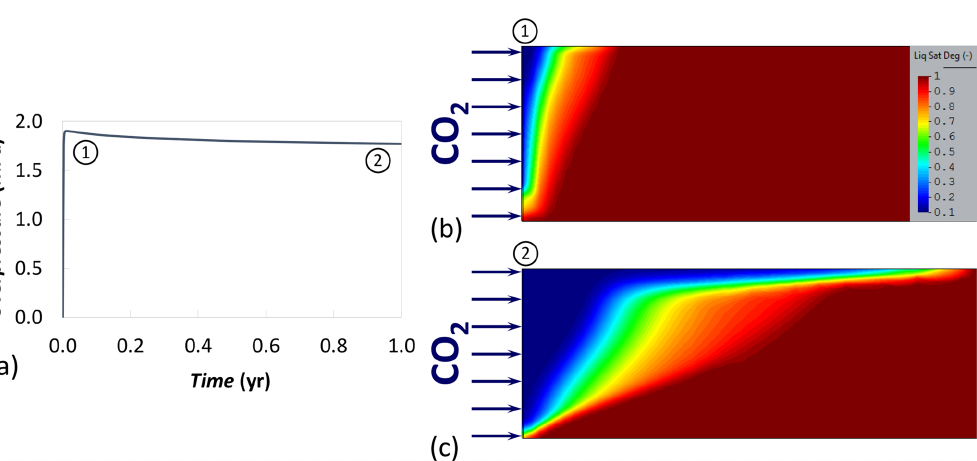
Figure 3. (a) CO 2 pressure evolution when injecting 1Mtyr − 1 of CO 2 through a vertical well in a 100m thick aquifer with an intrinsic permeability of 10 − 13 m 2 and a radius of 100km; (b) the CO 2 plume shape at the beginning of injection, coinciding with the peak in injection pressure (see number 1 in panel a ); and (c) the CO 2 plume once gravity override dominates and the capillary fringe has been developed, leading to a slight pressure drop (see number 2 in panel a ). The color bar displaying the liquid saturation degree in (b) applies for both (b) and (c)